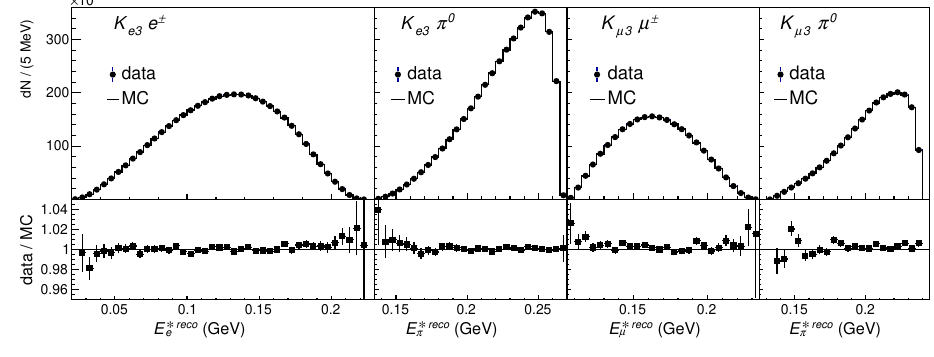
Figure 7. Reconstructed lepton energy E ∗ reco data (after background subtraction) and simulated samples according to the fit results using the Taylor expansion model, and corresponding Data / MC ratios. Simulated distributions according to fit results using other parameterizations cannot be distinguished within the resolution of the plots.